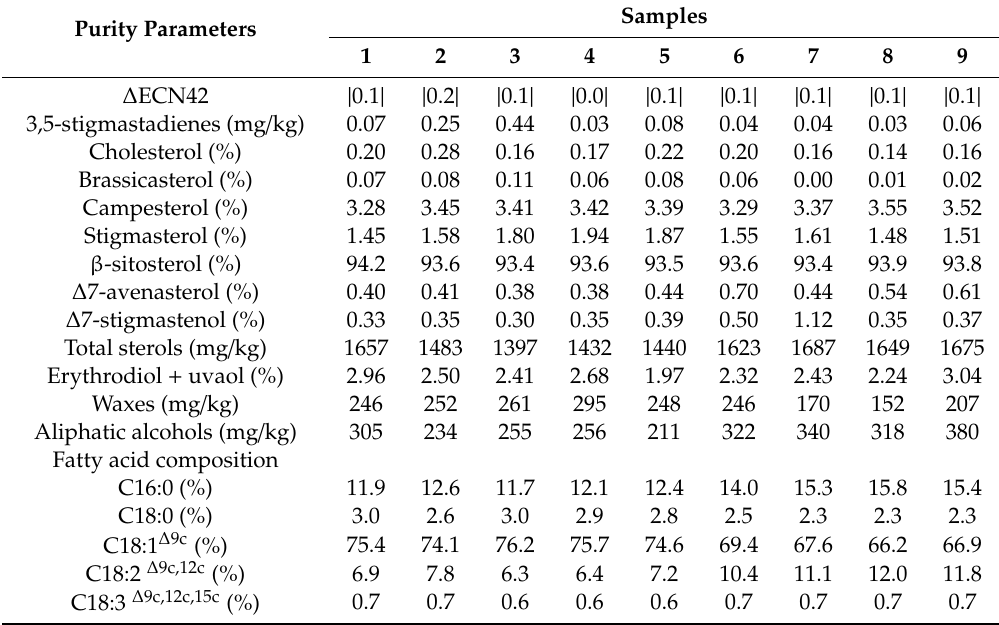
Table 2. Quality parameters of selected lampante